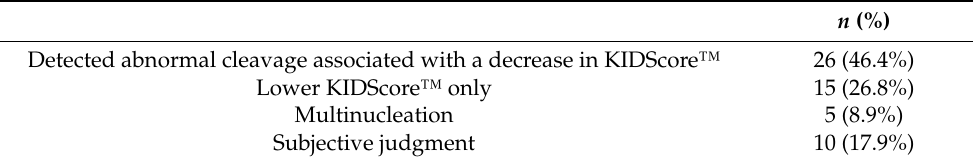
Table 2. Reasons for a change in the embryo selection process for transfers on day 3 or 5 (KIDScore™ available). Values are shown as n